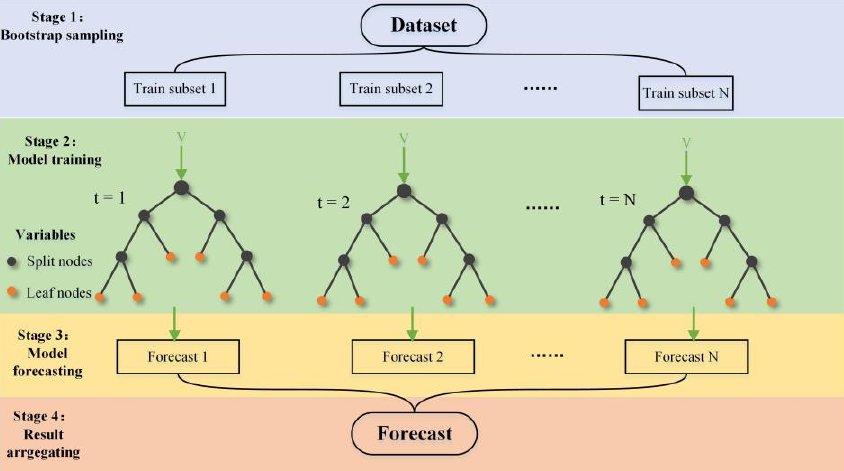
Figure 2. Diagram of the random forest (RF) algorithm.